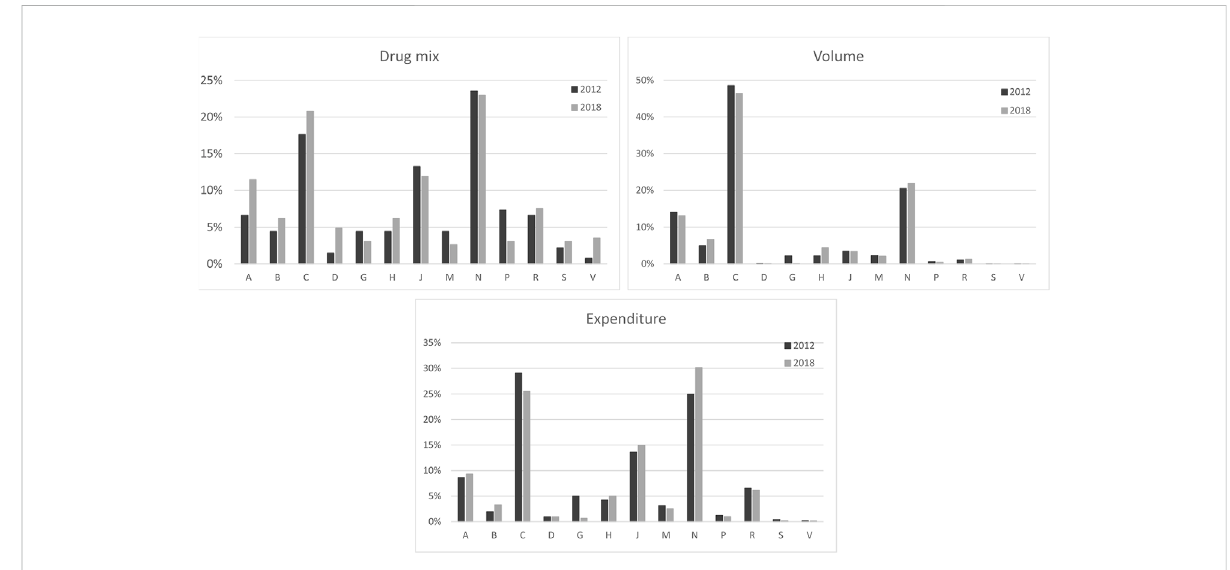
FIGURE 1 Distribution of the drug mix, volume, and expenditure by the major classes of medicines in 2012 and in 2018. Minas Gerais, Brazil.